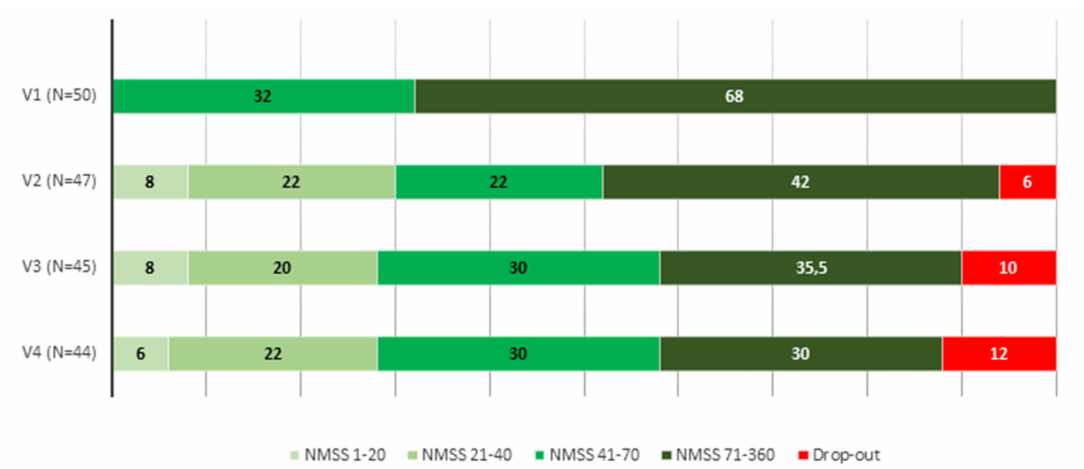
Figure 3. NMS burden (% of cases) with regards to the NMSS total score (0–20, slight burden; 21–40, moderate burden; 41–70, severe burden; 71–360 very severe burden) at V1, (baseline), V2 (1 months ± 7 days), V3 (3 months ± 15 days) and V4 (6 months ± 15